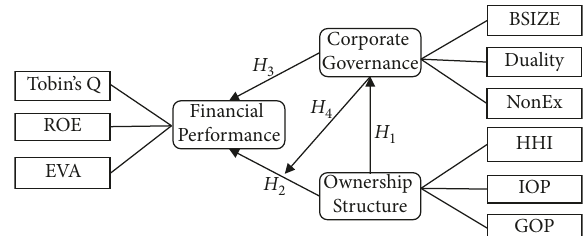
Figure 1: Conceptual framework and relationship between the research